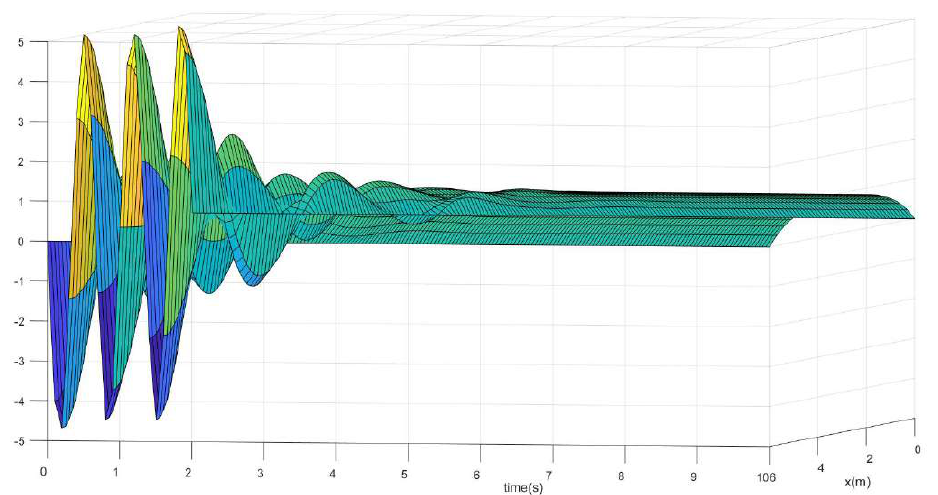
Figure 1. Solution u of (21)–(23) without control in 3D.